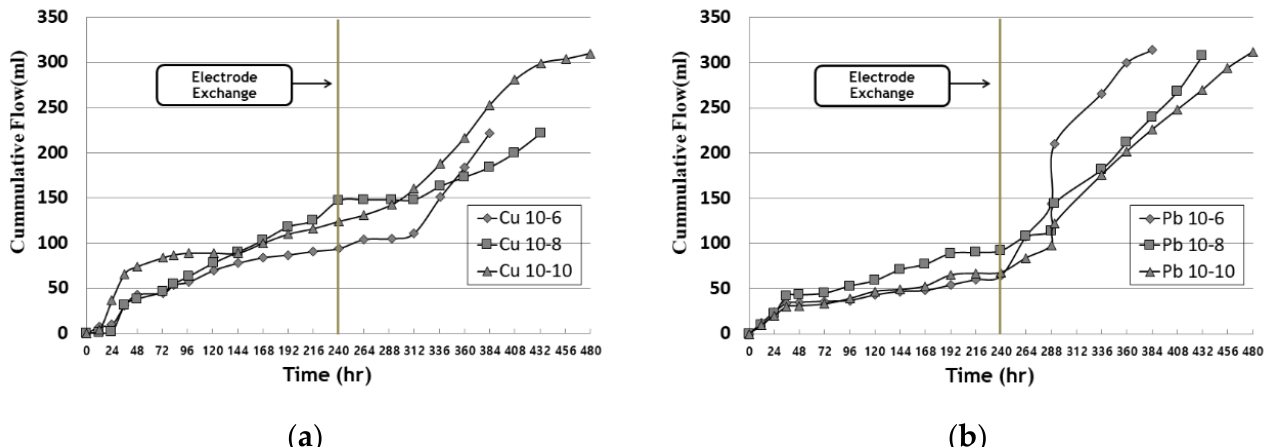
Figure 6. Cumulative outflow during EK experiment: ( a ) copper; ( b ) lead.